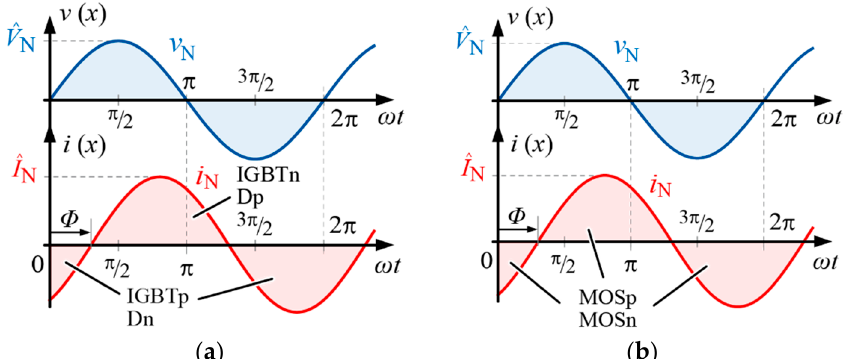
Figure 6. Current stress semiconductors of a three-phase six-switch rectifier for ( a ) an IGBT-based and ( b ) a MOSFET-based converter stage.